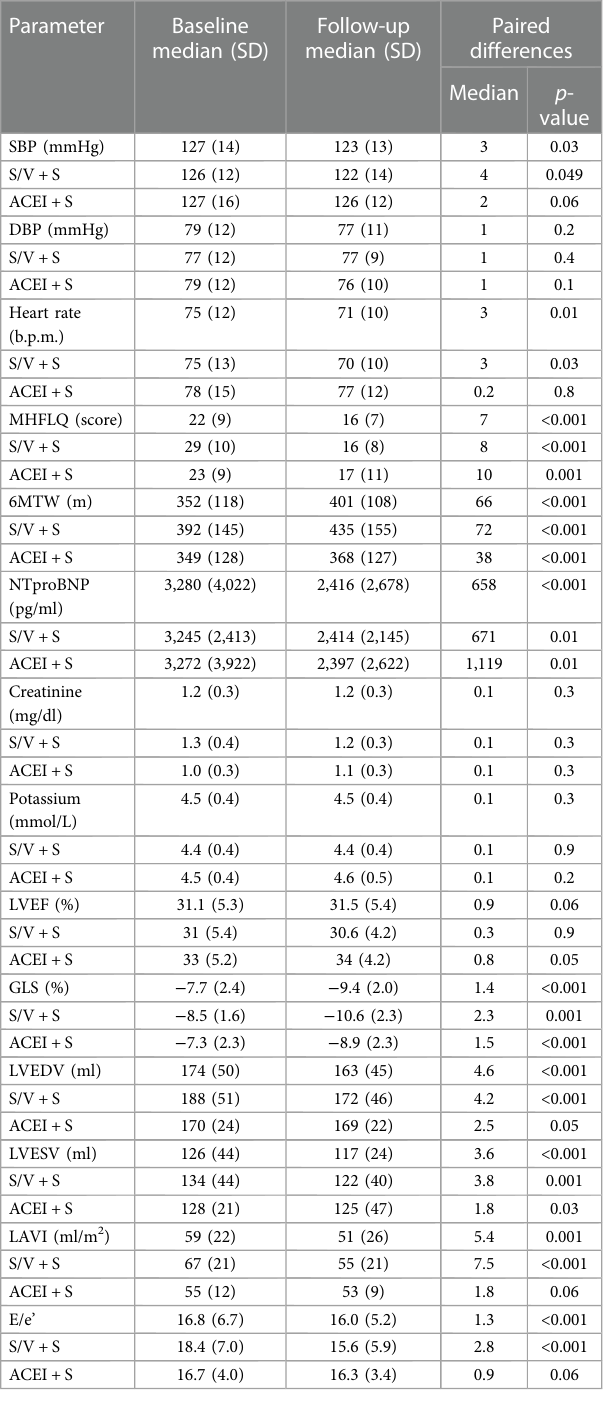
TABLE 2 Changes in parameters during the study ( n =78). TABLE 3 Number of patients whose GLS and LVEF changed during the